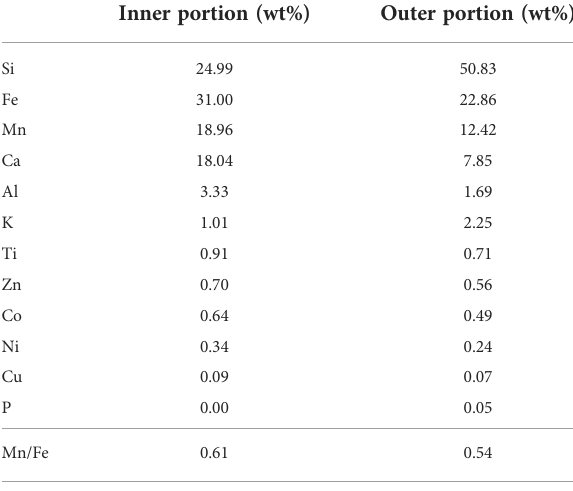
TABLE 1 Elemental composition of the inner and outer portions of